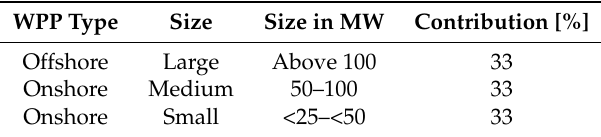
Table 1. Size and Share of three WPPs connected to the Power